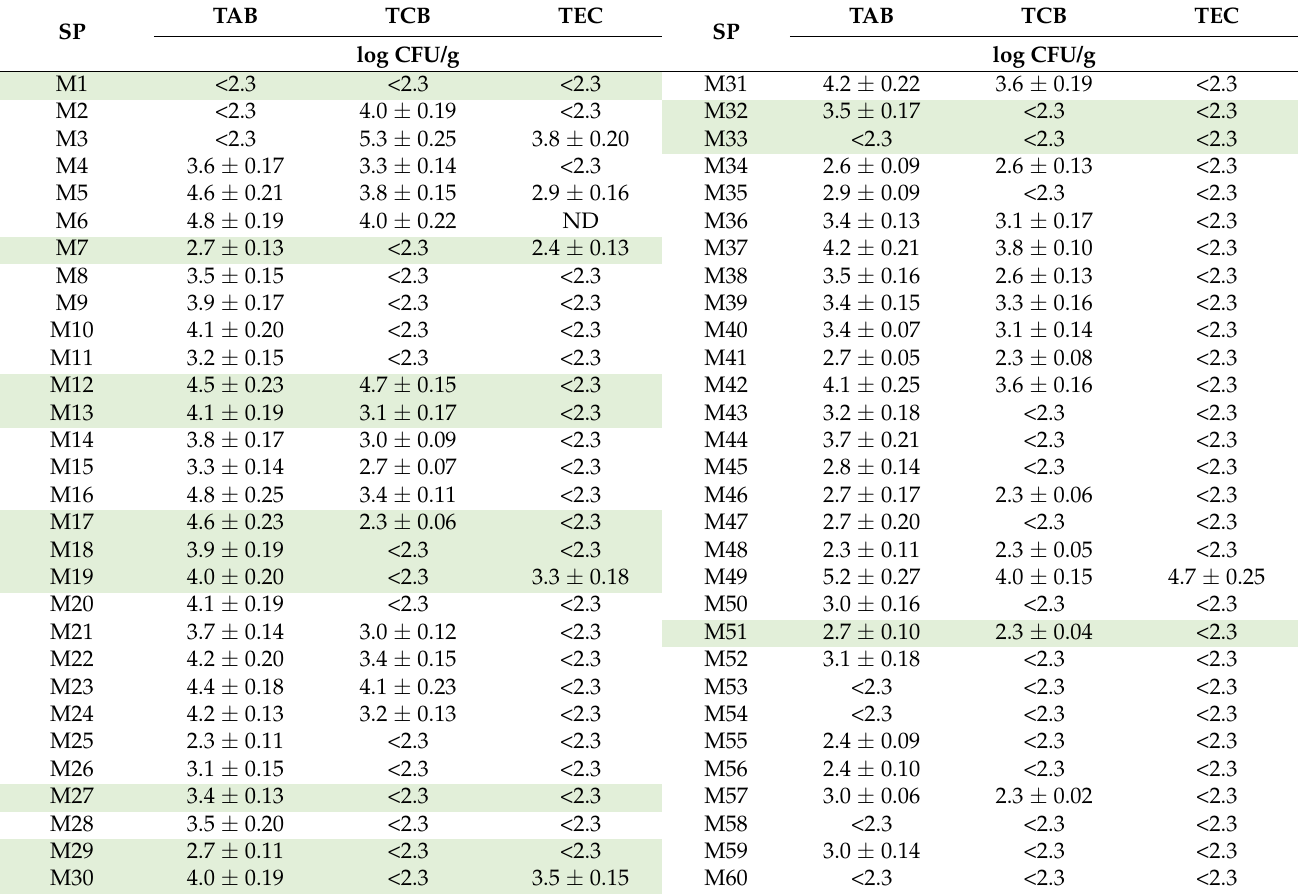
Table 5. Number of total aerobic and indicator bacteria in samples of flour and powder.